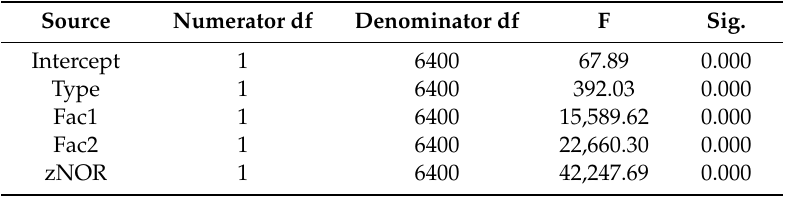
Table 8. Type III tests of fixed e ff ects a